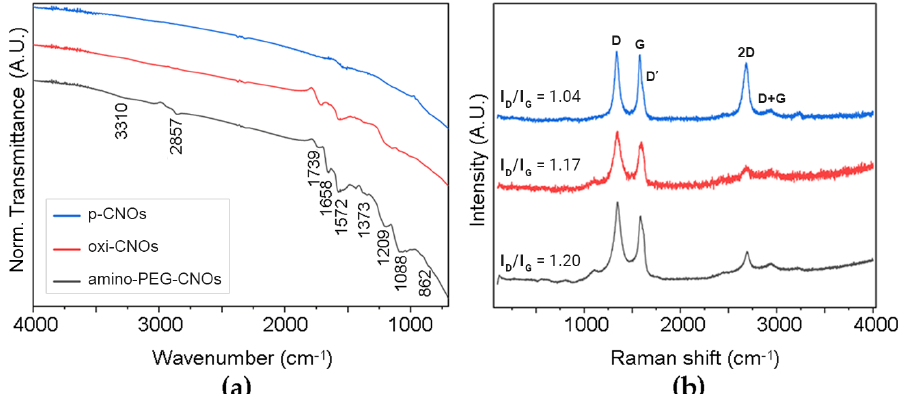
Figure 3. Spectra of p ‐ CNOs, oxi ‐ CNOs and amino ‐ PEG ‐ CNOs from analysis by ( a ) ATR ‐ FTIR and ( b ) Raman spectroscopy. ( b ) Raman